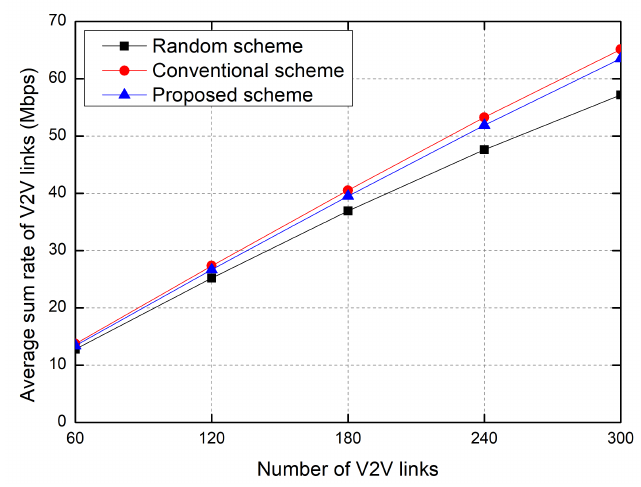
Figure 6. Average sum rate of V2V links.